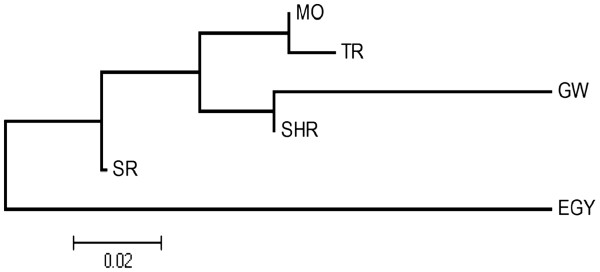
Neighbour-joining (NJ) dendrogram showing the genetic distance between Phlebotomus papatasi populations from Sudan and Egypt. Relationships based on Wright’s FST statistics